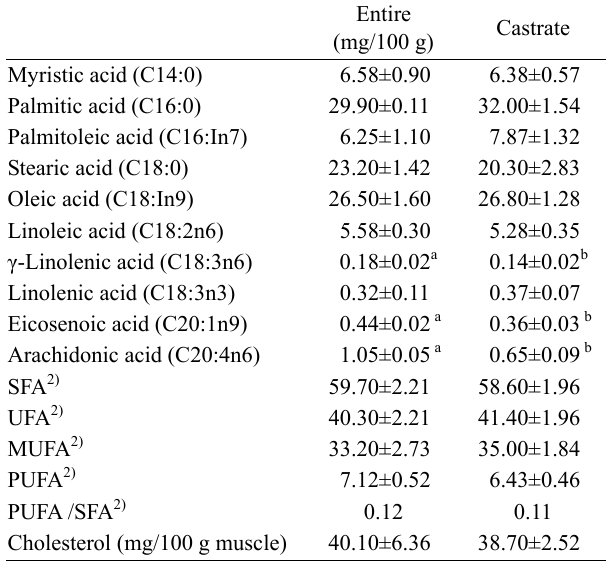
Table 3. Fatty acid composition and cholesterol content of entire and castrate elk muscle Table 4. Free amino acid composition (%) of entire and